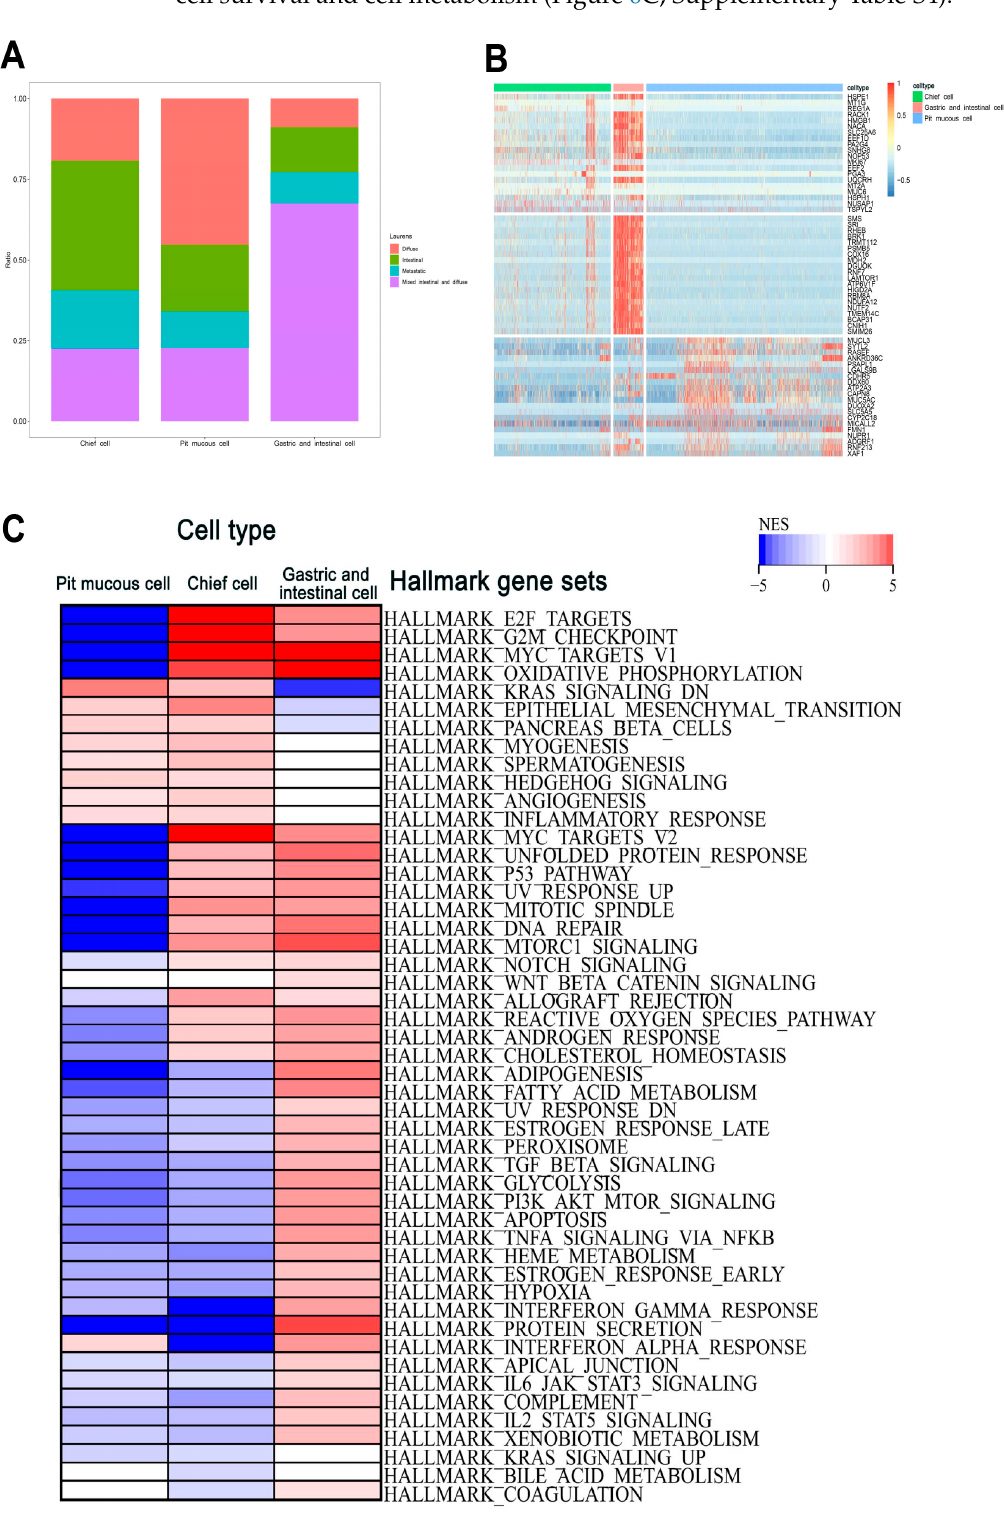
Figure 5. Cellular atlas of the malignant epithelial cell subtypes. ( A ) The GSEA results show the enrichment gene sets in malignant epithelial cells, and four of them were GC − associated gene sets. ( B ) tSNE plot showing the malignant epithelial cells seurat cluster, and Violin plots showing the expression distribution of subtype marker genes in five clusters. ( C ) Bubble plot showing the ex- pression levels of marker genes in three subtypes. ( D ) tSNE plot showing the subtypes for malignant epithelial cells.